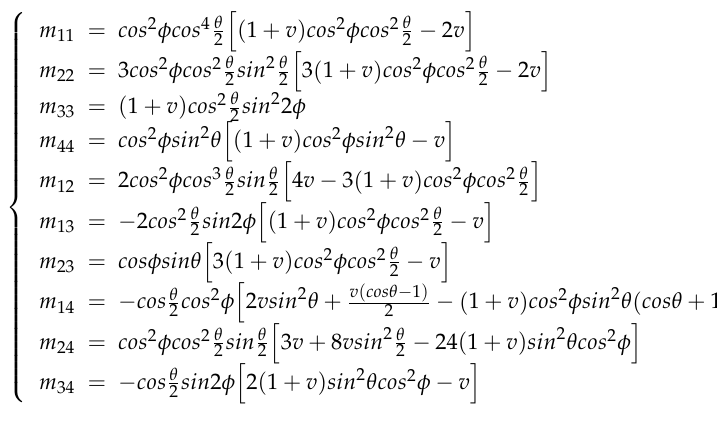
Table A3. The coefficients of Equation (12) under the plane stress